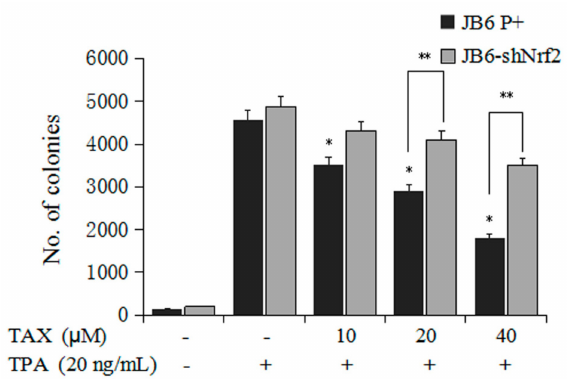
Figure 3. Inhibitory effect of TAX on the 12- O -tetradecanoylphorbol-13-acetate (TPA)-induced transformation of JB6 P+ and shNrf2-transfected JB6 P+ cells. The cells were maintained with TPA (20 ng/mL) alone or in a combination with TAX in a 5% CO 2 incubator at 37 ◦ C for 14 days. The colonies exhibiting anchorage-independent growth were counted under a microscope using ImageJ software. (National Institutes of Health, version 1.50a, http://rsbweb.nih.gov/ij). The graphical data are presented as the average of triplicate results from two independent experiments. * p < 0.05, indicating a significant decrease in colony formation relative to that of the JB6 P+ cells treated with TPA alone in soft agar; ** p < 0.05, indicating significant differences between the JB6 P+ cells group and JB6-shNrf2 cells group in the same treatment.